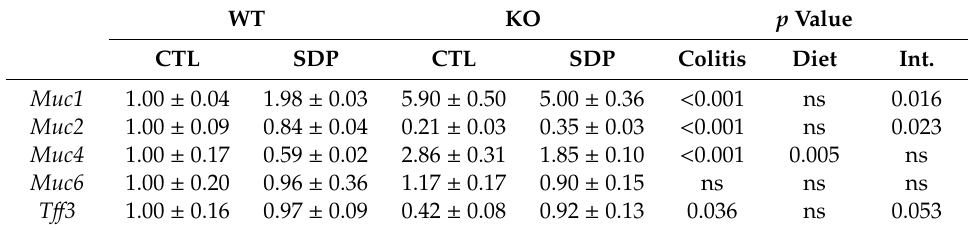
Results are expressed as mean ± SEM ( n = 3–5 mice / group). CTL, control; Int., interaction between colitis and dietary factors; Muc1, mucin 1; Muc2, mucin 2; Muc4, mucin 4; Muc6, mucin 6; ns, nonsignificant; SDP, spray-dried porcine plasma; T ff 3, trefoil factor